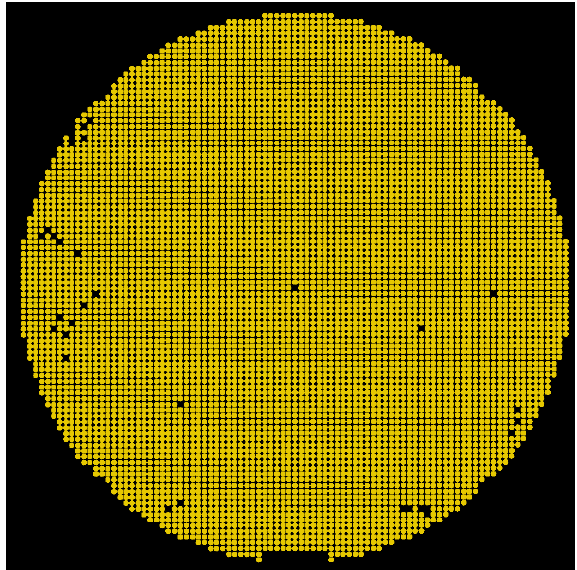
Figure 8. Die detection result of original SAT image.